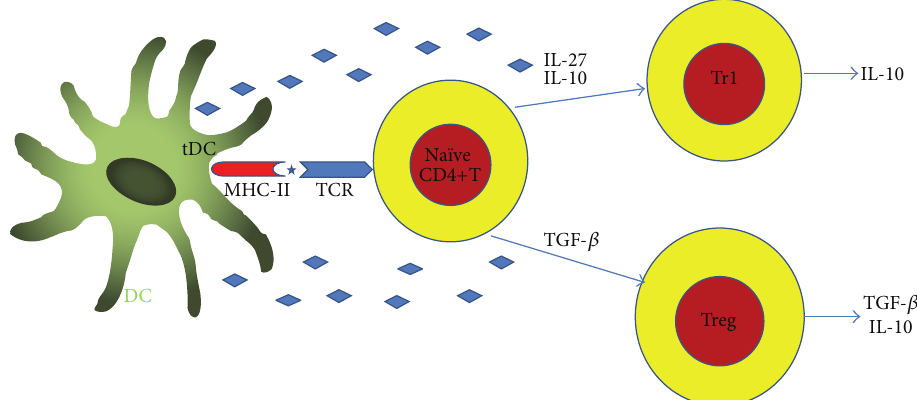
Figure 1: Tolerogenic dendritic cells play their tolerogenic role through promote regulatory T cells differentiation. The tolerogenic DCs regulate autoreactive T cells by inducing anergy, apoptosis, phenotypically skewing, and/or Treg cells or tolerogenic DCs can be induced through the induction of T regulatory cells, such as Tr1 and CD4+, CD25+, and Foxp3